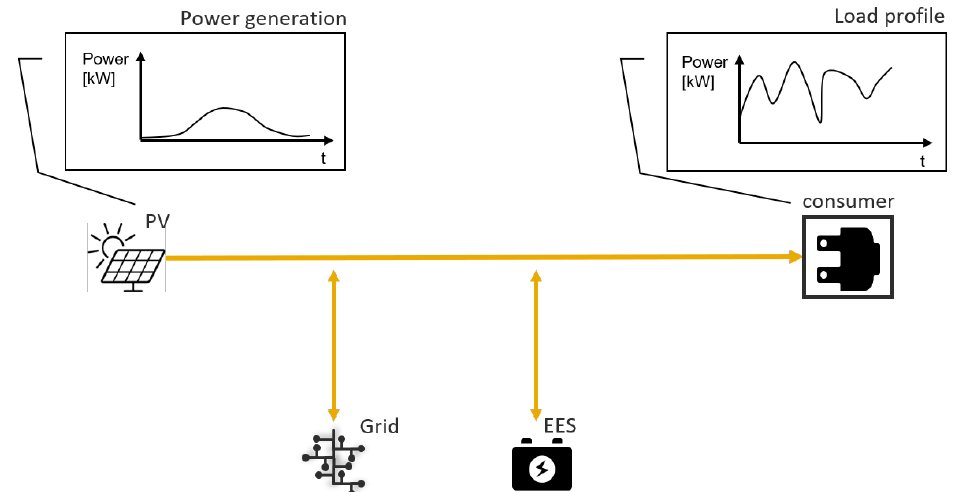
Figure 9. System topology of the microgrid (the use-case MG resulted from project work, mentioned in the Acknowledgments).